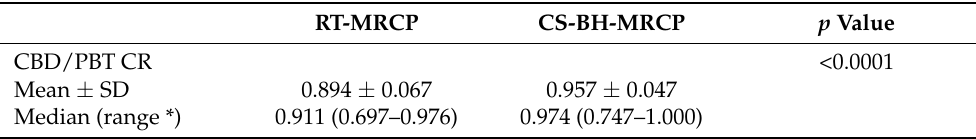
Table 5. Quantitative evaluation: comparison of the common bile duct (CBD) to peri-biliary tissues (PBT) contrast ratios (CR) between the two sequences RT-MRCP and